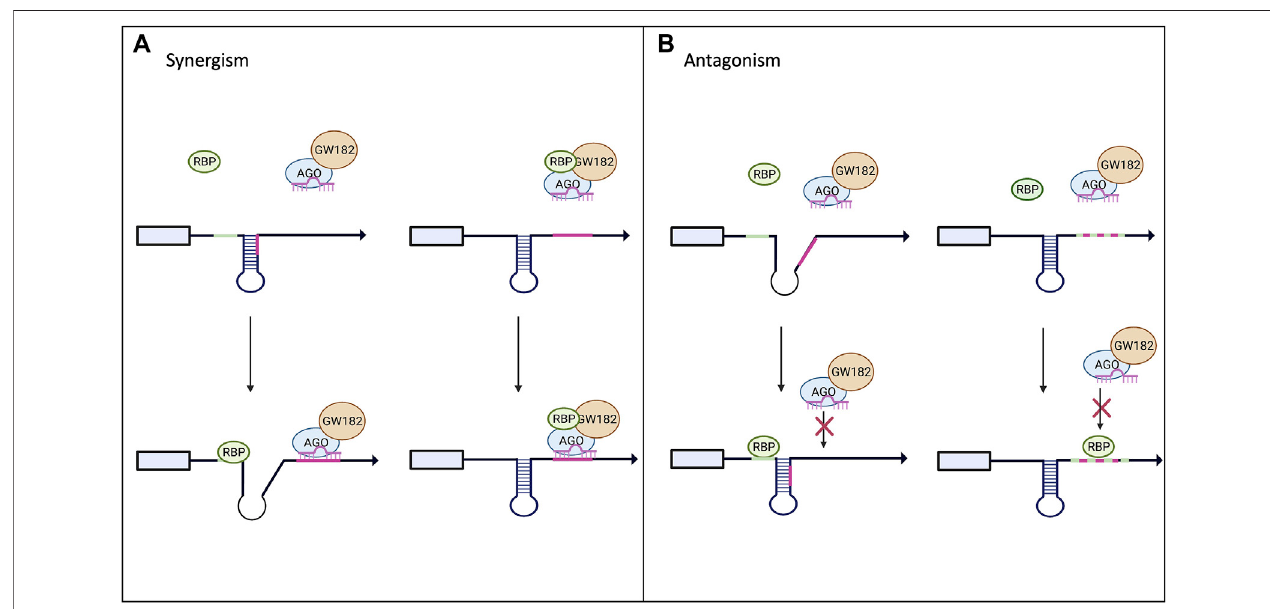
FIGURE 3 | Interplay between RBPs and miRNAs on miRISC-mediated gene expression. Panel (A) shows potential models of synergism between RBPs and miRNAs.UponbindingtothemRNAtargettheRBPcanalterthesecondarystructureandincreasetheexposureofthemiRNAbindingsiteallowingforincreasedmiRISC binding. The RBP could also bind to the miRISC and increase its binding af fi nity to its target mRNA. (B) Highlights the possible antagonistic mechanism between RBPs andmiRNAs.RBPbindingtoitstargetcouldalterthesecondarystructure,decreasingthemiRISC ’ saccesstoitsbindingsite.RBPsandmiRNAcanalsocompete for the same binding site and the RBP can outcompete and block the miRISC from binding to its site (Loffreda et al., 2015).